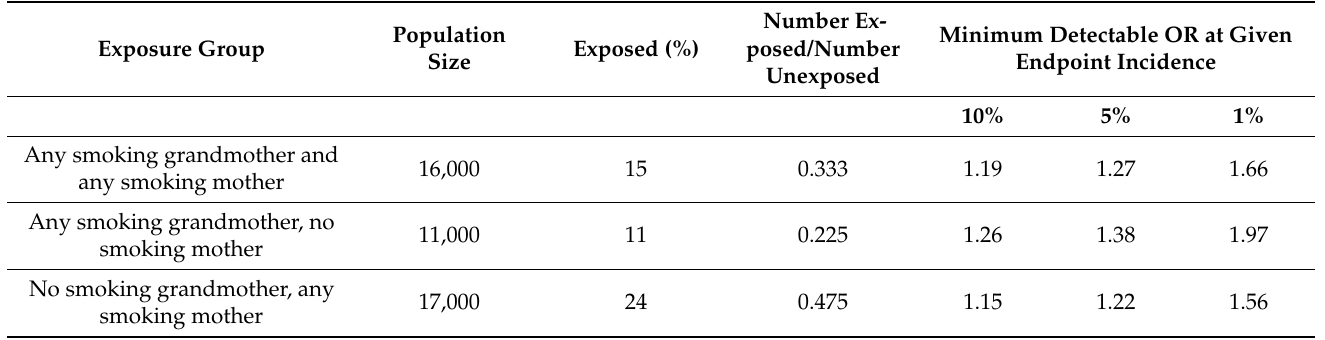
Table 3. Estimation of the lowest OR detectable as statistically significant (95% CI) with assumed power of 90%. Exposure Group